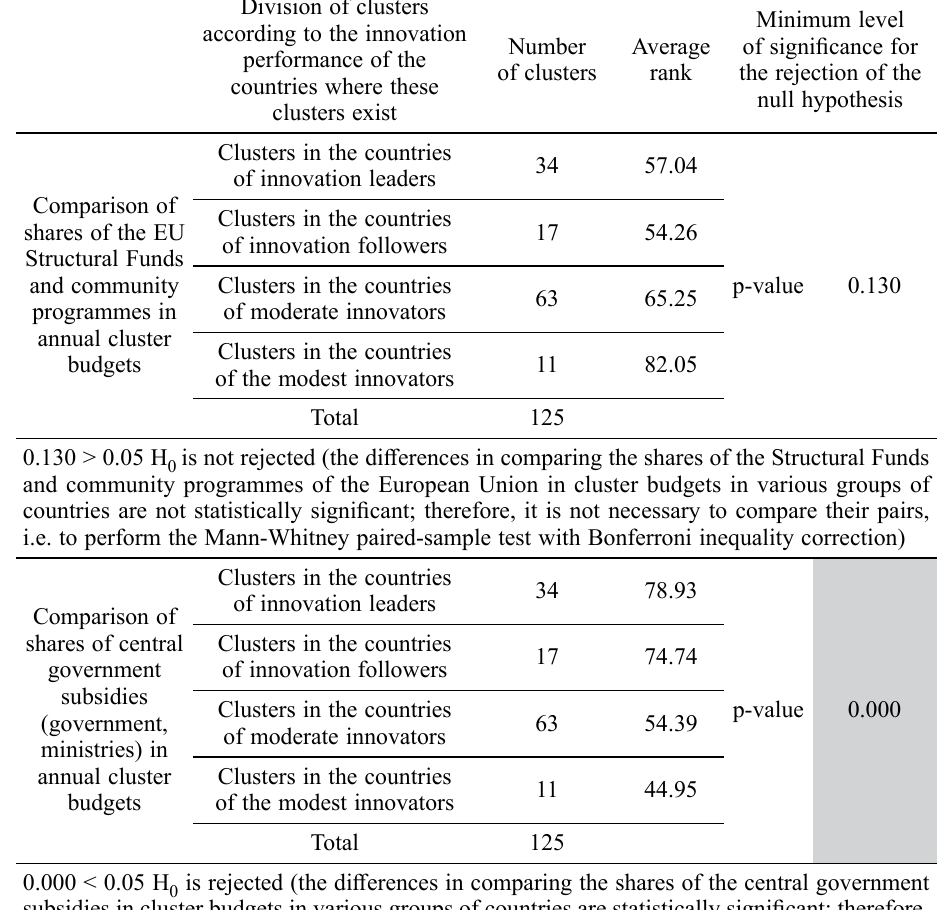
Table 1. Comparison of shares of the Structural Funds and community programmes of the European Union, central government subsidies, regional self-government subsidies and local self-government subsidies in annual cluster budgets in various groups of countries Division of clusters Minimum level according to the innovation of significance for Number Average performance of the the rejection of the of clusters rank countries where these null clusters exist